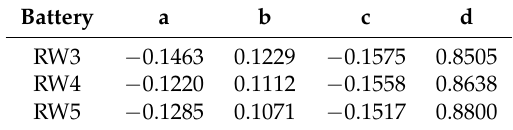
Table 4. Estimates of model coefficients for each battery.